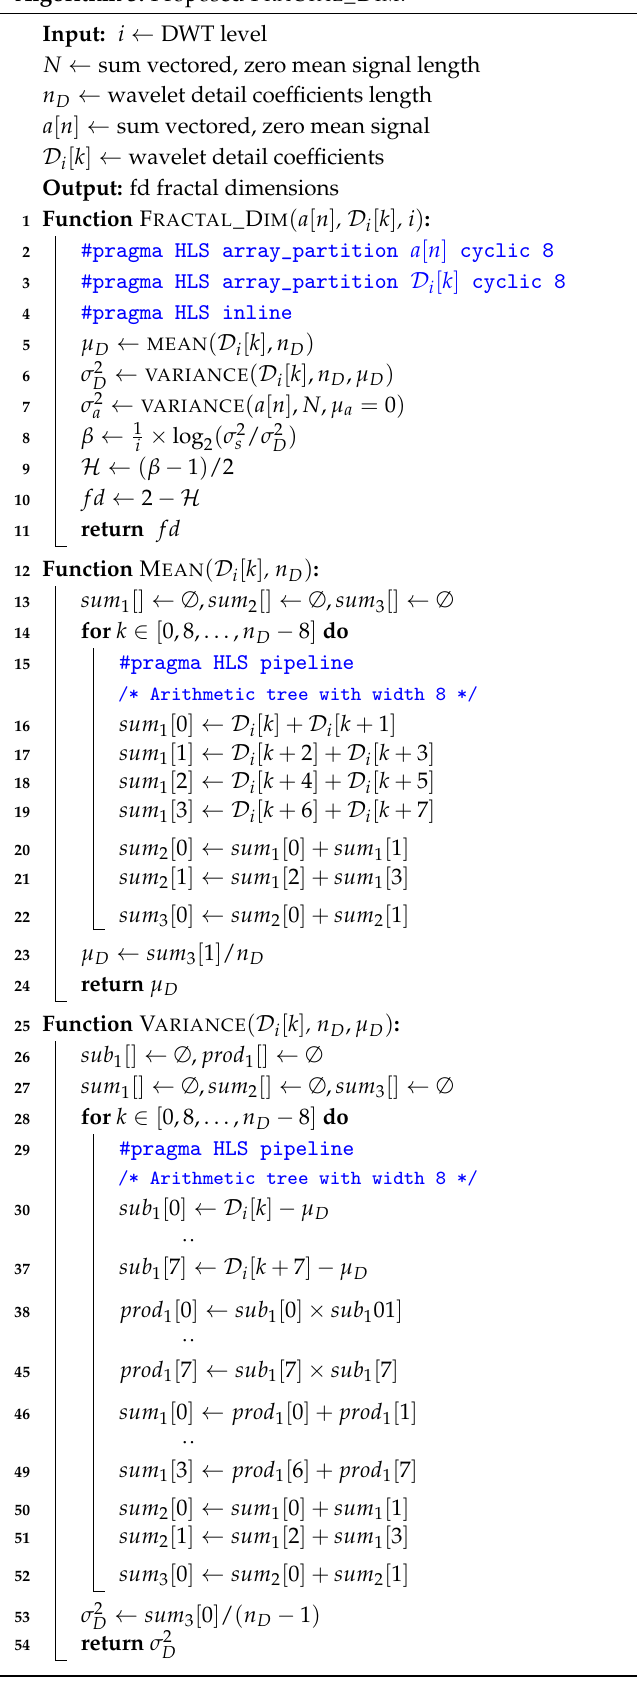
Algorithm 3: Proposed F RACTAL _D IM